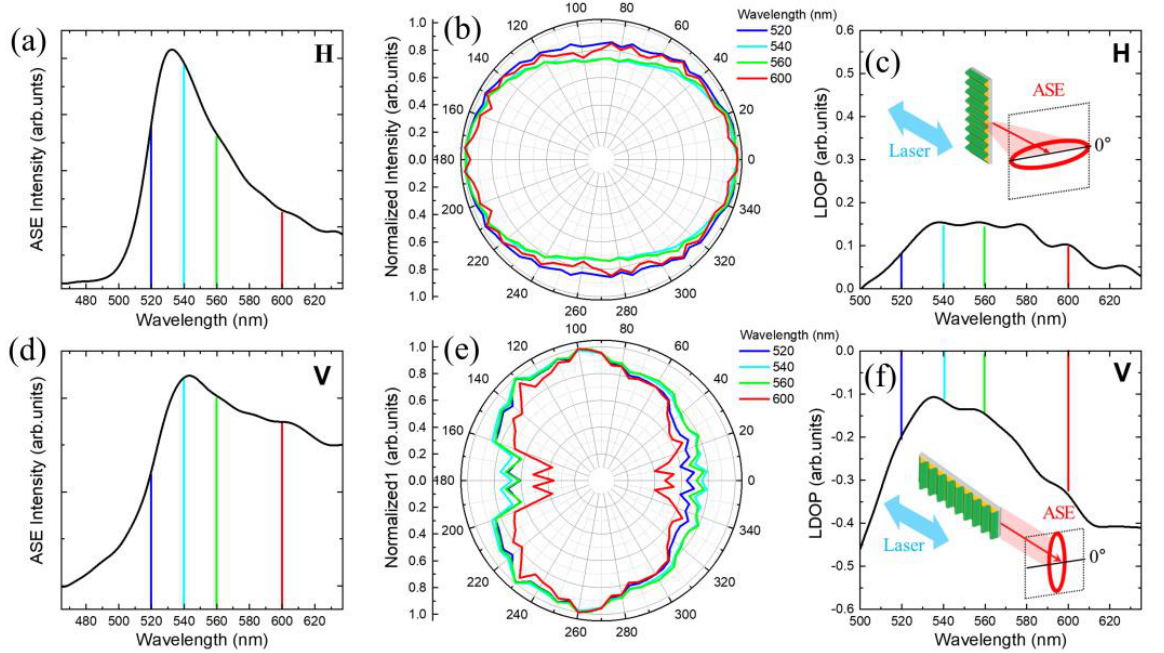
Figure 2. ( a , b ) Horizontally and ( d , e ) vertically polarized excitation; the ASE spectrum and analyzer angle dependence are shown for selected wavelengths of blue (520 nm), cyan (540 nm), green (560 nm), and red (600 nm), respectively. ( c , f ) Linear degree of polarization (LDOP) was estimated for horizontally (H) and vertically (V) polarized excitation, respec- tively.